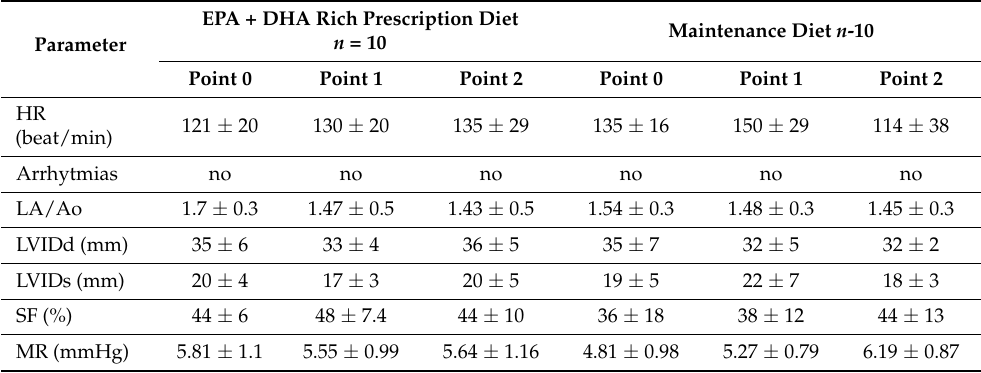
Table 6. Electro- and echocardiographic variables at individual time points in 10 dogs fed an EPA + DHA rich prescription diet and 10 dogs fed a maintenance diet. Data are presented as mean ± standard deviation. There were no arrhythmias found and no differences between both